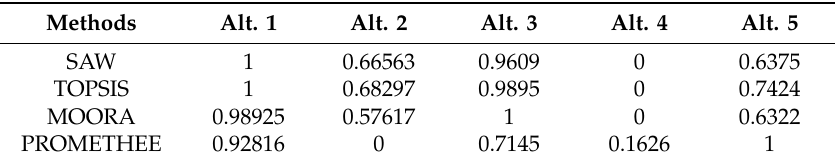
Table 2. Normalized MADM result in the range of [0, 1].